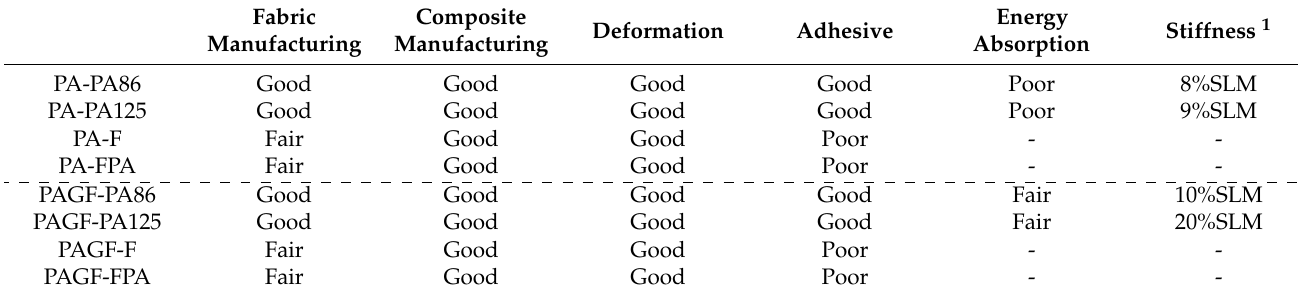
Table 11. Overview of the composites